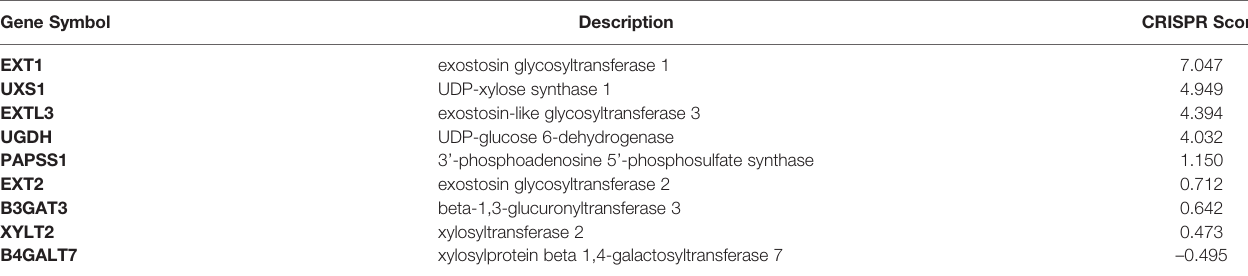
Top nine enriched sgRNA gene targets (symbol and description) are presented with their calculated CRISPR